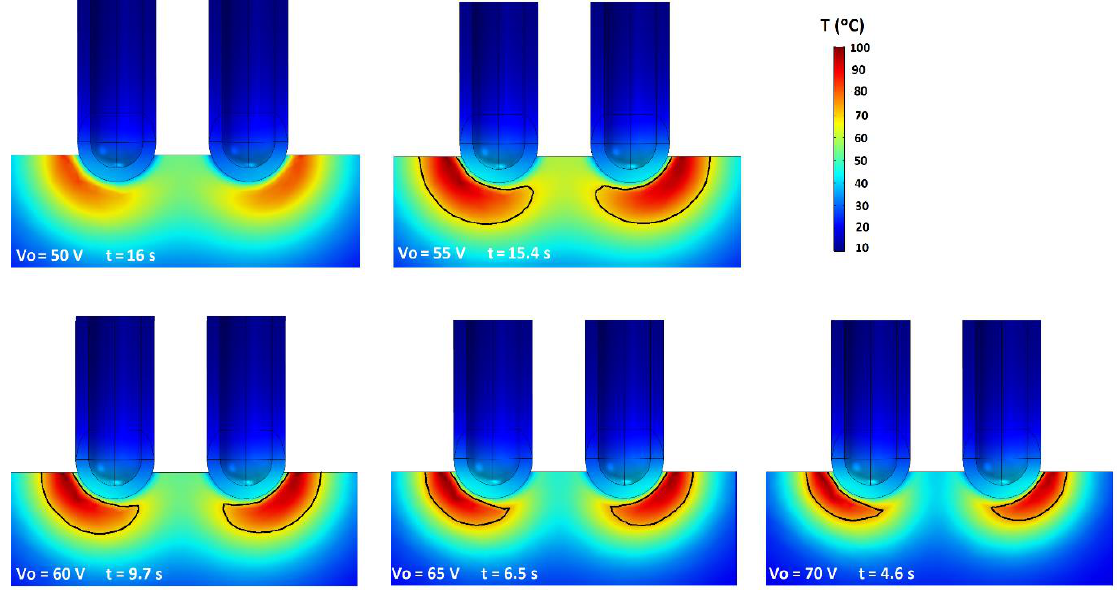
Figure 7. Temperature distribution (°C) and isosurface Ω = 1 (black line) for the MM in the symmetry plane of the geometry representing cases of V 0 = 50 (t = 16 s), 55 (t = 15.4 s), 60 (t = 9.7 s), 65 (t = 6.5 s), and 70 V (t = 4.6 s). The times in each graph are the times that satisfied the stop criterion.